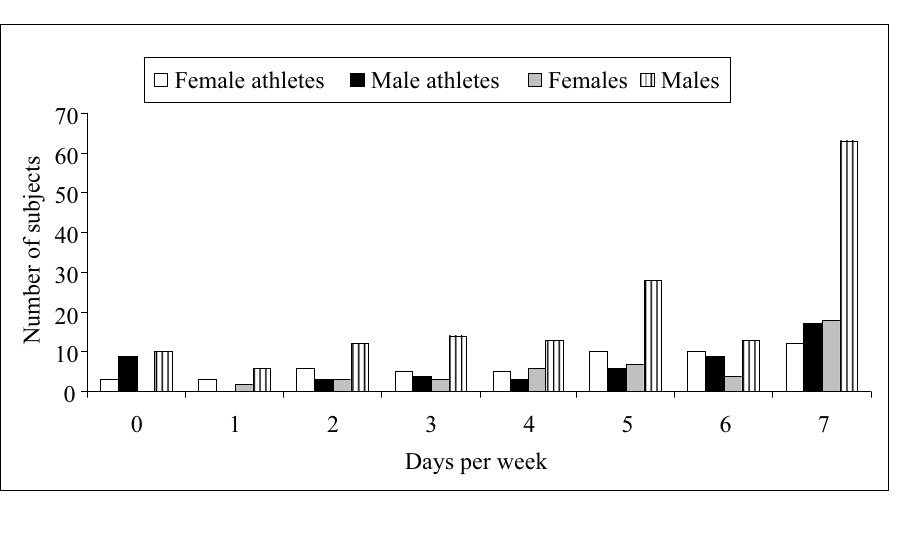
Figure 3. Frequency of walking, which includes activities at work and at home, walking to Figure 4. The hours of sitting per day as indicated by the travel from place to place or any other kinds of walking for recreation, sport, exercise or subjects leisure, as indicated by the subjects